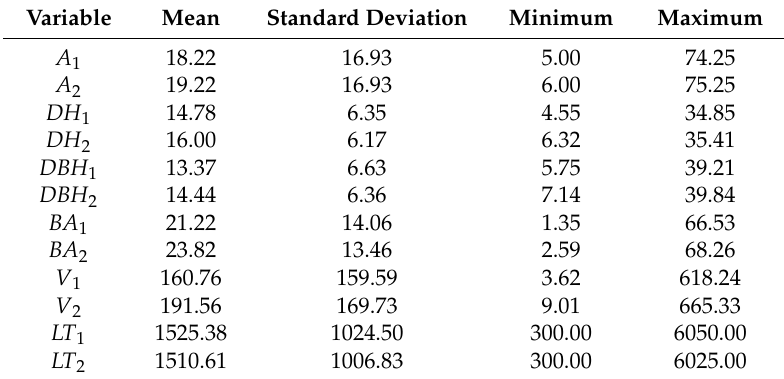
Table 1. Statistical summary of 66 permanent sampling plots used in the fit of the dynamic